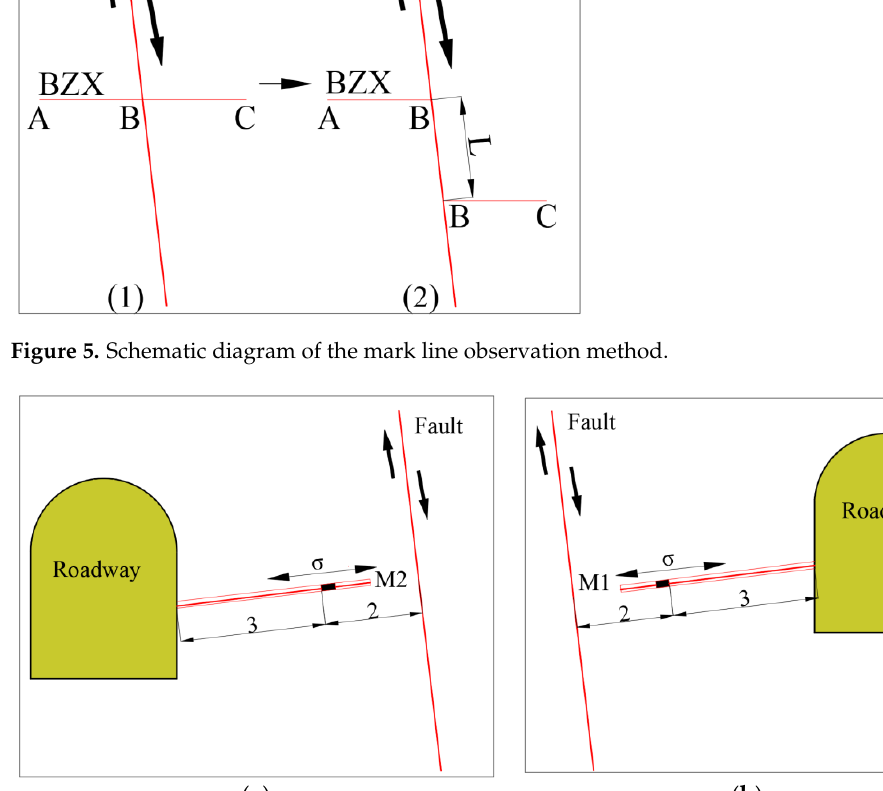
Figure 6. Installation diagram of the bolt stress meter, they should be listed as: ( a ) Installation schematic diagram of the bolt stress meter in the footwall of the fault; ( b ) Installation schematic diagram of the bolt stress meter in the hangingwall of the fault.